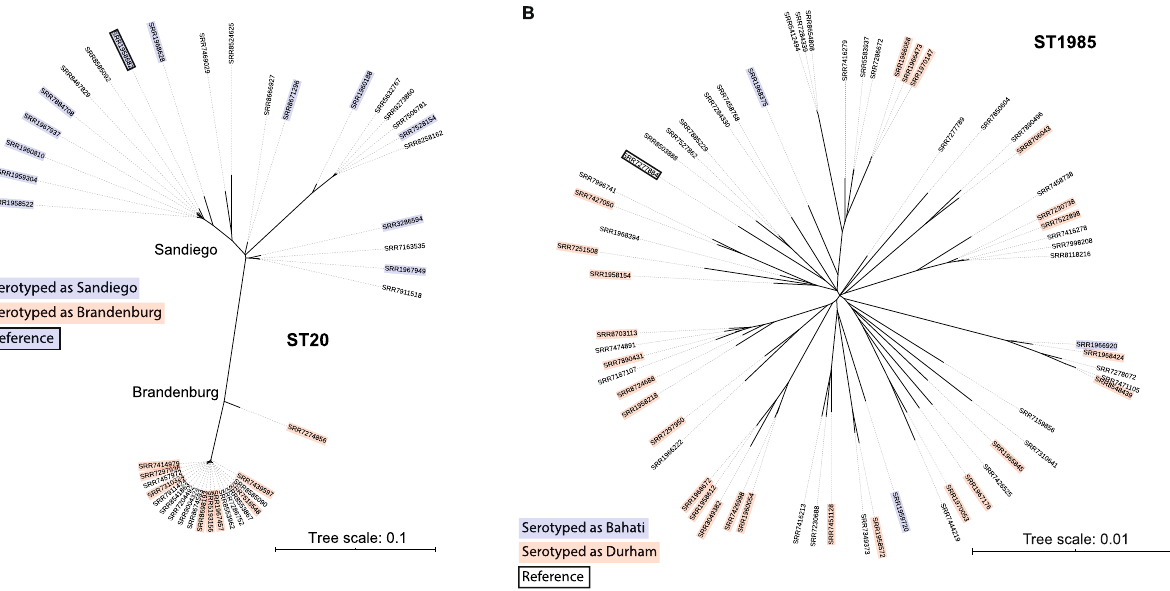
Figure 1. ( A ) Phylogenetic analysis of MAC types Brandenburg and Sandiego (ST20). Representative strains were serotyped and serotype result is highlighted in blue (Sandiego) or red (Brandenburg). ( B ) Phylogenetic analysis of MAC types Bahati and Durham (ST1985). Representative strains were serotyped and serotype result is highlighted in blue (Bahati) or red (Durham).